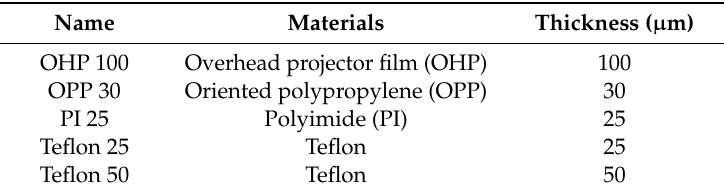
Table 2. Thickness of each type of